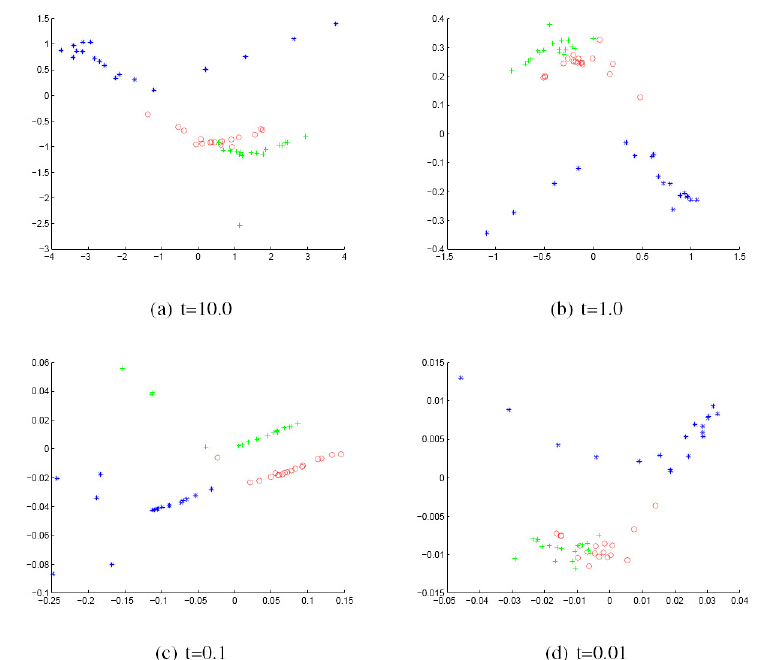
Figure 6. MDS embedding obtained using HD for Columbia Object Image Library (COIL) data represented by the sectional curvatures residing on the edges. The x and y axes are the embedding coordinates corresponding to the leading two dimensions of the MDS embedding. The differently-coloured symbols denote different object classes.